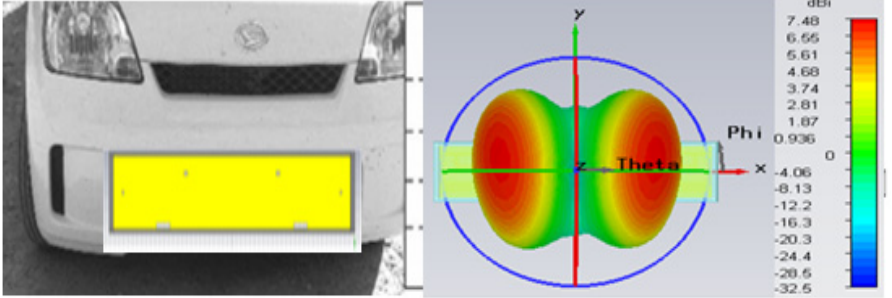
Figure 5. The three-dimensional radiation pattern of the tag antenna at 920 MHz.